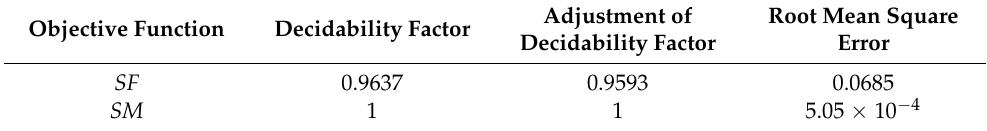
Table 7. Significance assessment value.